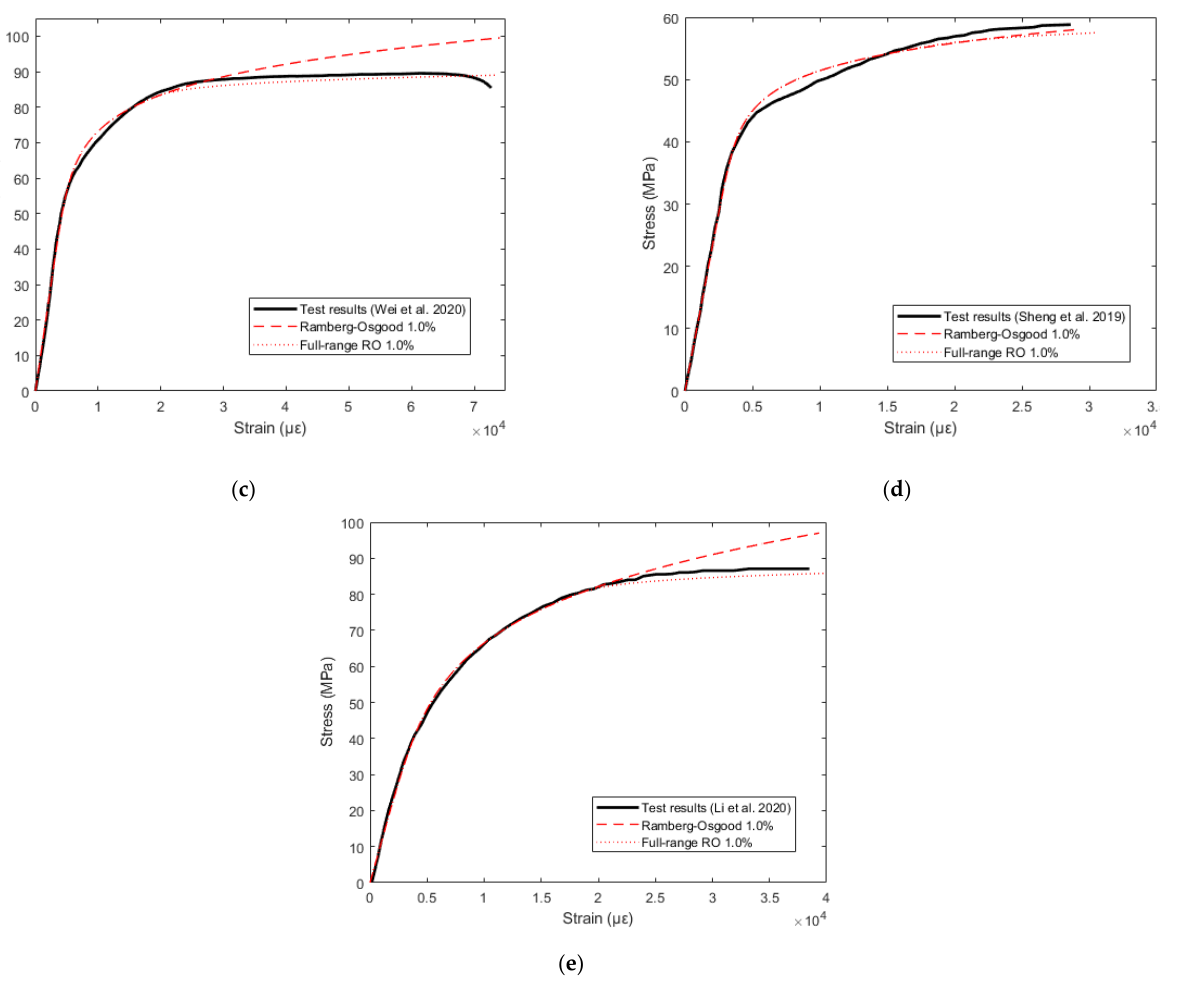
Figure 8. Performance of the full-range RO vs the classical RO with a 1.0% proof stress for bamboo scrimber: ( a ) Li et al., 2019 [19], ( b ) Dongsheng et al., 2013 [45], ( c ) Wei et al., 2020 [46], ( d ) Sheng et al., 2019 [47]and ( e ) Li et al., 2020 [48].